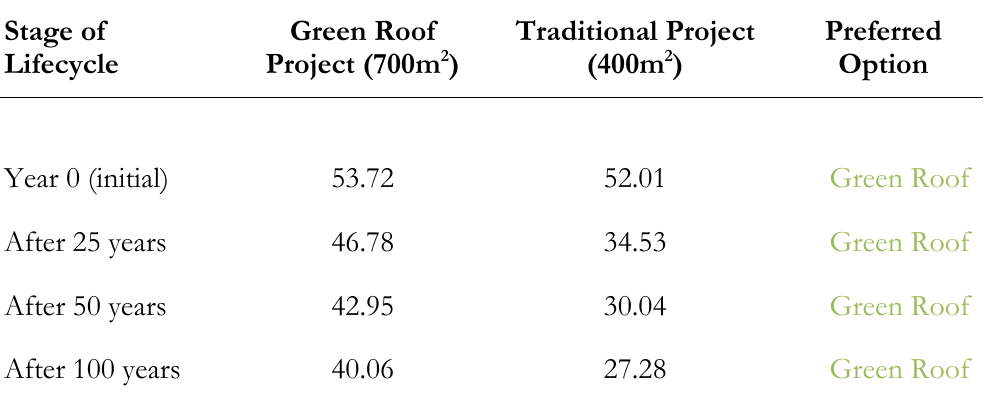
Table 3: Alternative assessment (relative to size) Stage